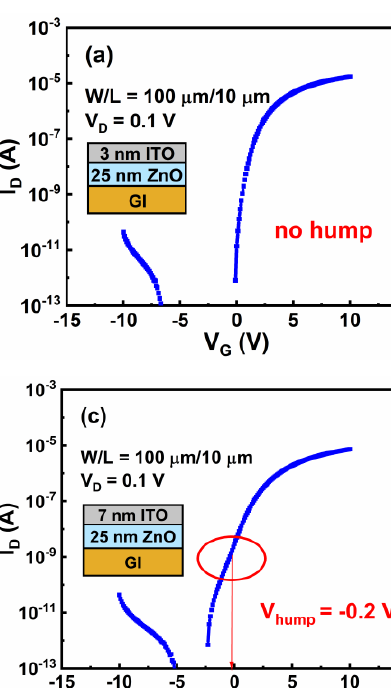
Figure 6. I D – V G curves for group A TFTs. The t ZnO values are ( a ) 10 nm, ( b ) 20 nm, ( c ) 30 nm, and ( d ) 40 nm. The t ITO value is 9 nm. Table 2. Electrical parameters of ZnO/ITO TFTs, including µ FE , V hump , and V ON .